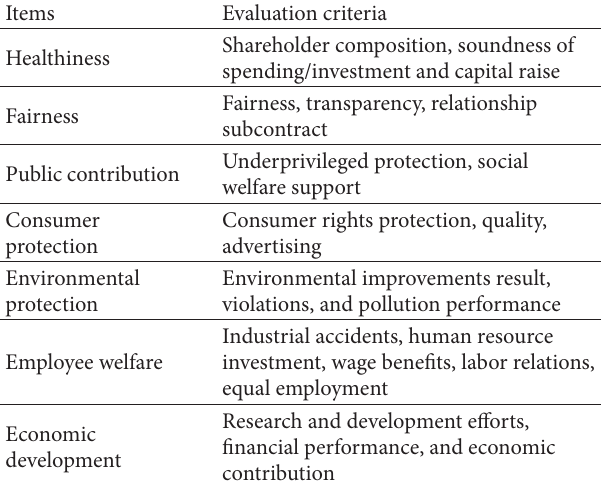
Table 2: Evaluation item for CSR.